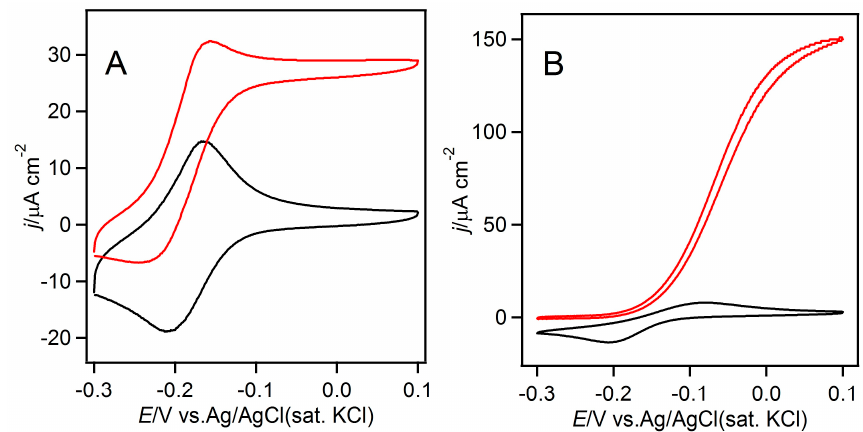
Figure 1. Cyclic voltammograms of ( A ) 0.1 mM toluidine blue and( B ) 0.1 mM 1,4-naphthoquinone in the presence (red) or absence (black) of FAD-GDH (1.0 μ M) in a phosphate buffer (pH 7.0) containing 0.1 M glucose. Scan rate of 10·mV·s − 1 .